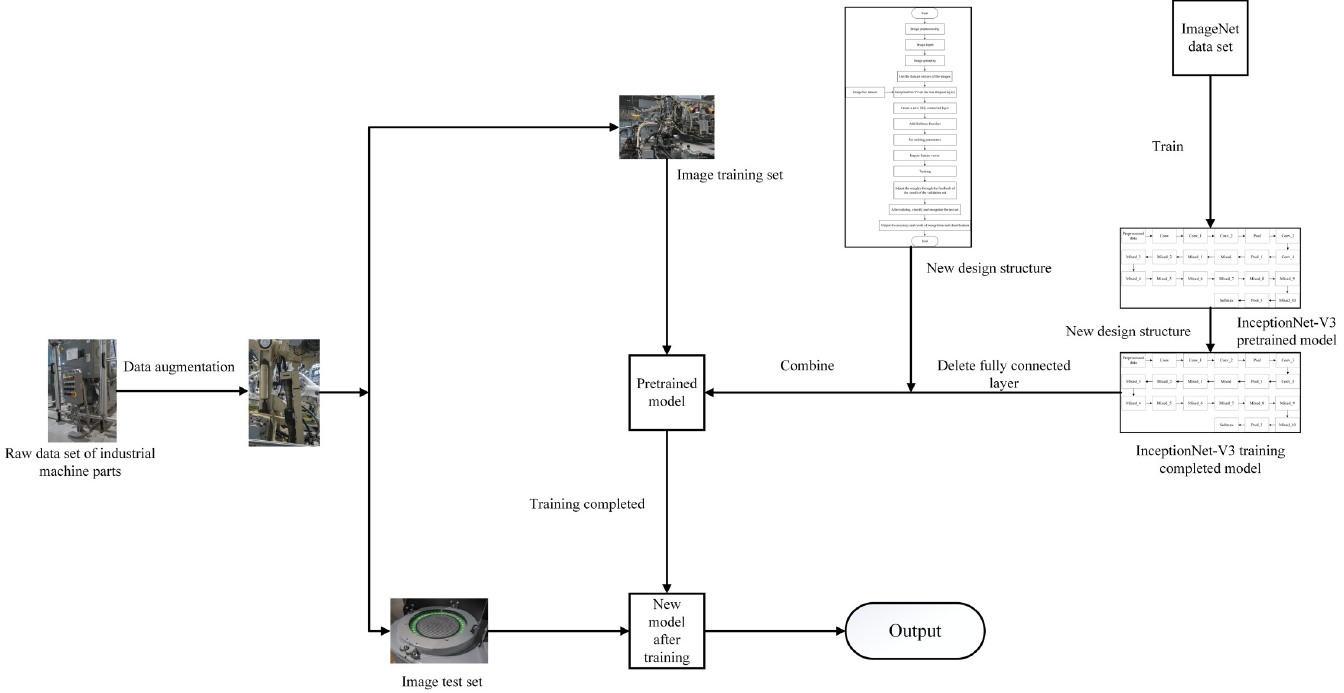
Fig 4. Classification and recognition process of industrial machine parts based on transfer learning.